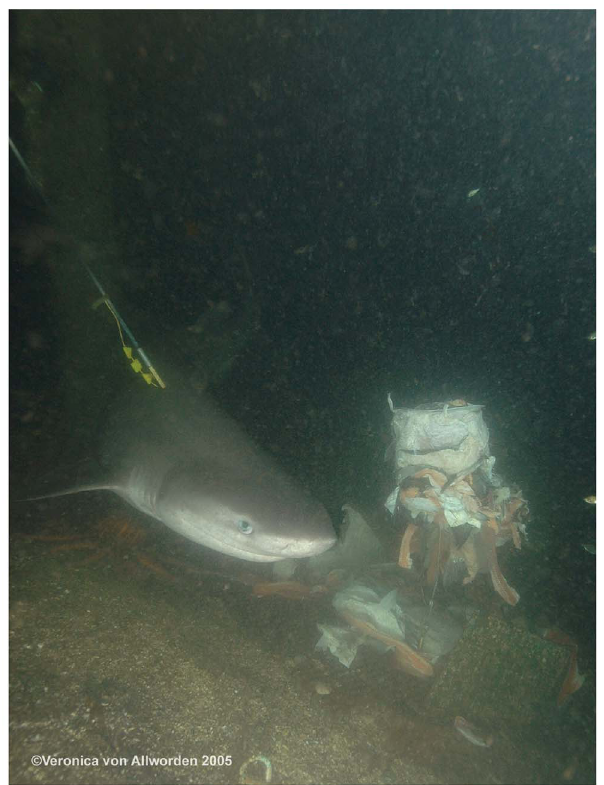
Figure 2. Picture of a shark swimming between the protected contact diver cage (not pictured on the left) and the bait box (on the right) while an external tag is being implanted via pole spear by SCUBA diver at the SA research station.